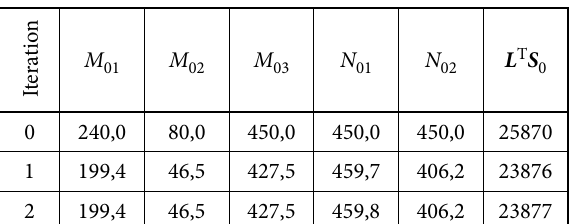
Table 2. Optimization results under stability and displacement constraints